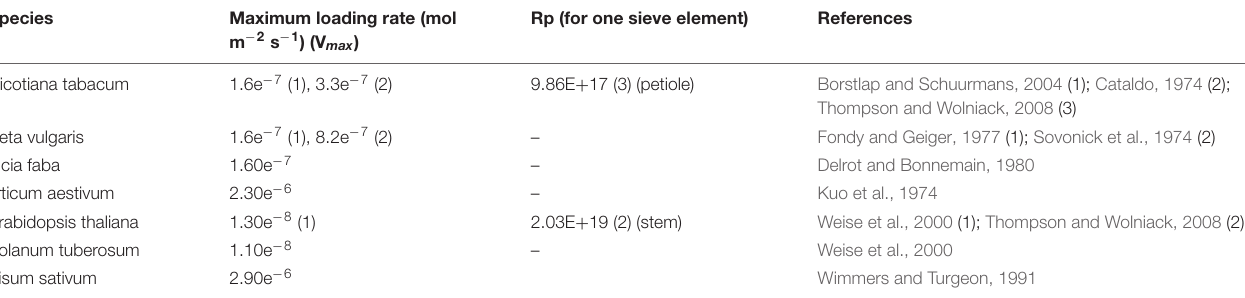
TABLE 3 | Data on available apoplasmic active loader maximum loading rate (V max ) and phloem anatomical characters to calculate R p . Species